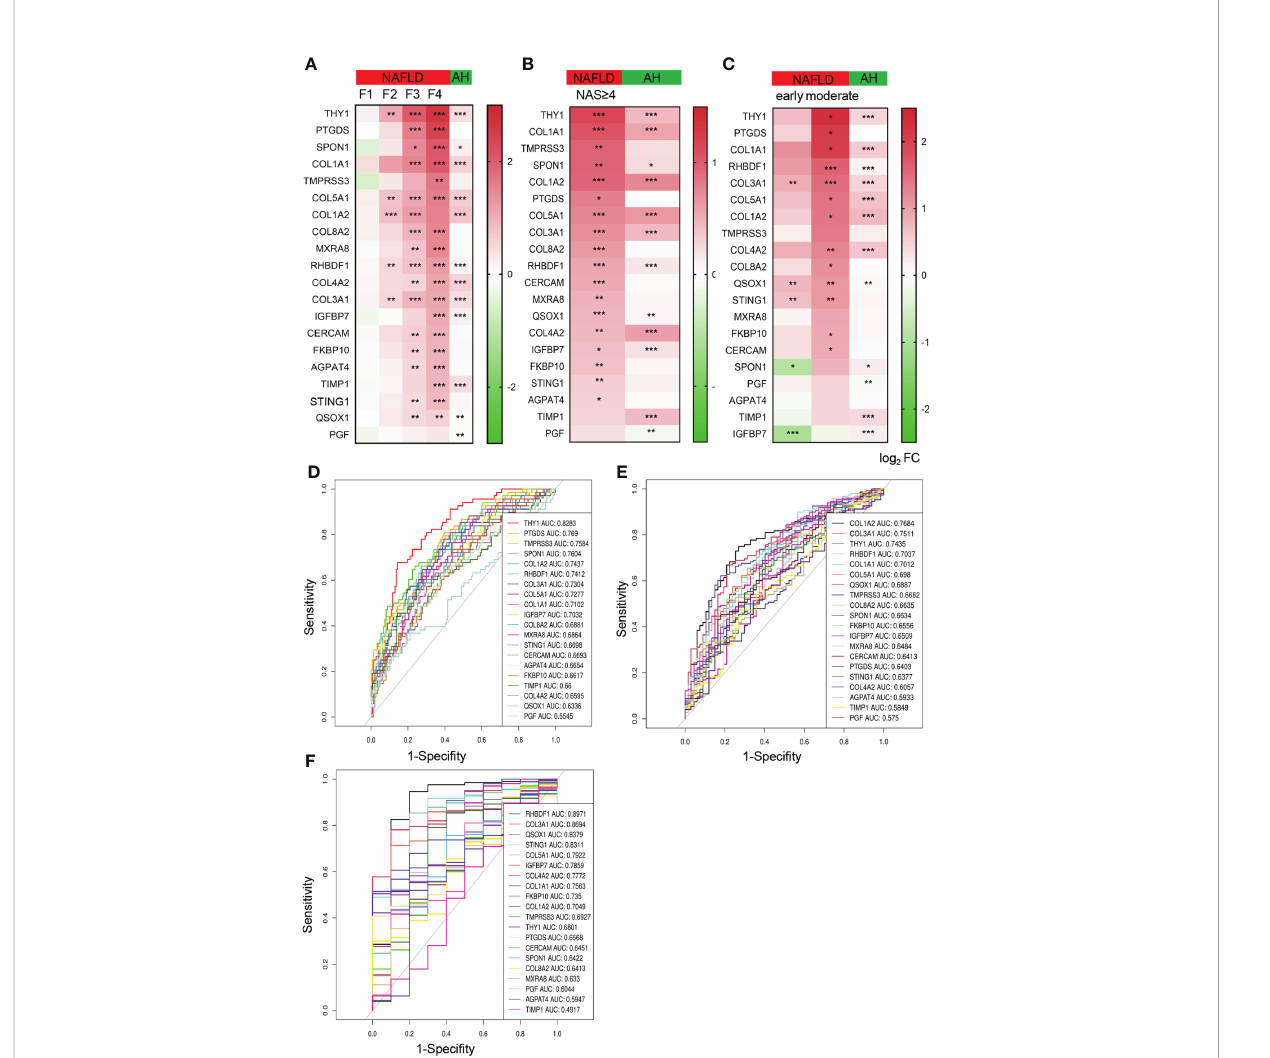
FIGURE 4 The expression pattern of the top 20 hub genes and their diagnostic value in the NAFLD progression. (A – C) Heatmap of the relative expression of top 20 hub genes in NAFLD and AH database, grouped by fi brosis stages (F0-F4) (A) , NAS (NAS<4 and NAS ≥ 4) (B) , disease stages (control, early and moderate) (C) . The colors represent log 2 fold change determined by RNA sequencing (NAFLD database) or chip array (AH database). Data are represented as means ± SEM. P value was adjusted in (A) . *P < 0.05, **P< 0.01 and ***P< 0.001. (D – F) ROC curves show the speci fi city and sensitivity of the 20 hub genes as biomarkers to recognize fi brosis stage of NAFLD (F<2 or ≥ 2) (D) , NASH (NAS <4 or ≥ 4) (E) and NAFLD (F) . ROC, receiver operating characteristic; AUC, area under the curve, AH, alcoholic